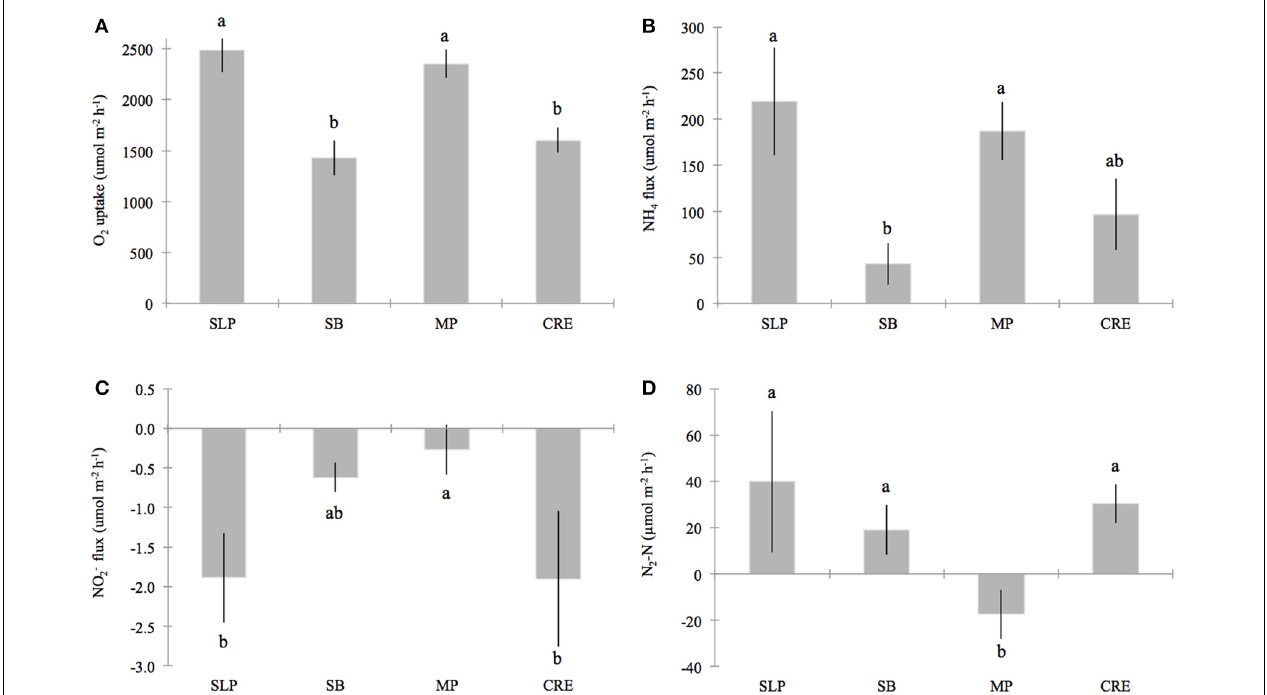
FIGURE 3 | Benthic fluxes for (A) oxygen (O 2 ) uptake, (B) ammonium (NH